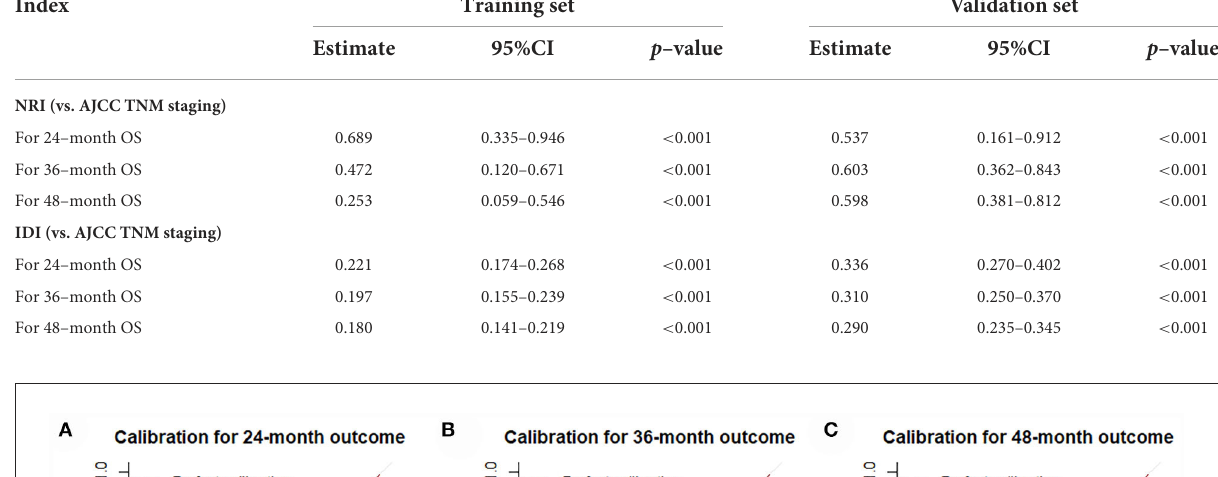
TABLE 5 NRI and IDI of the prognostic nomogram for POSNs patients with DM compared with TNM staging system.